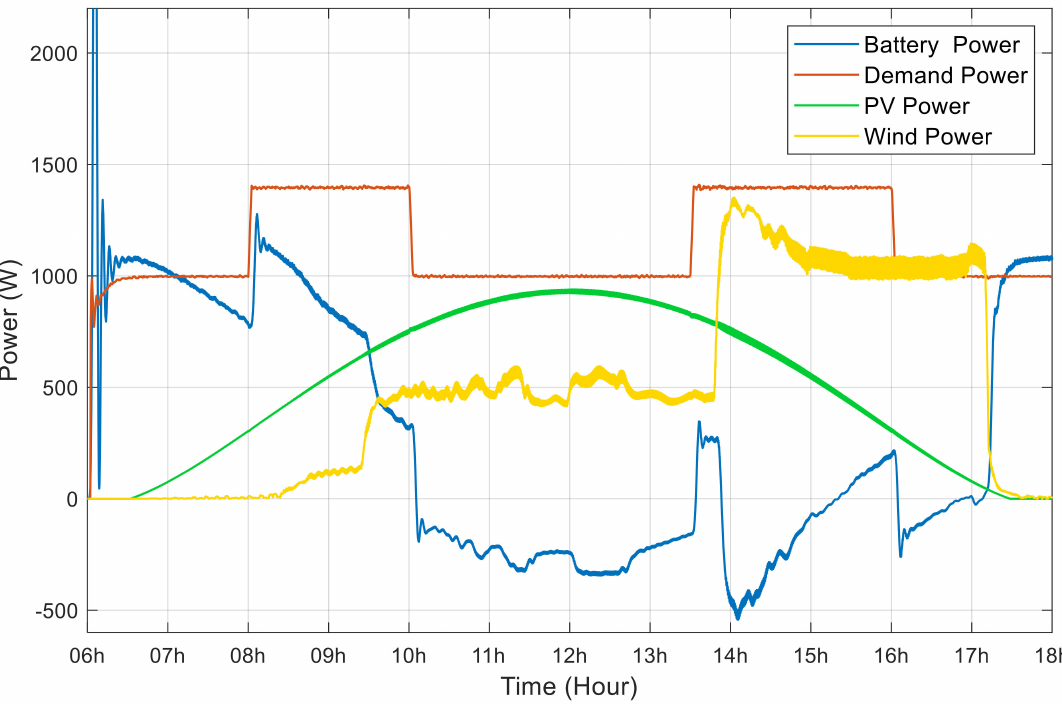
Figure 9. GPC control for autonomous operation mode.